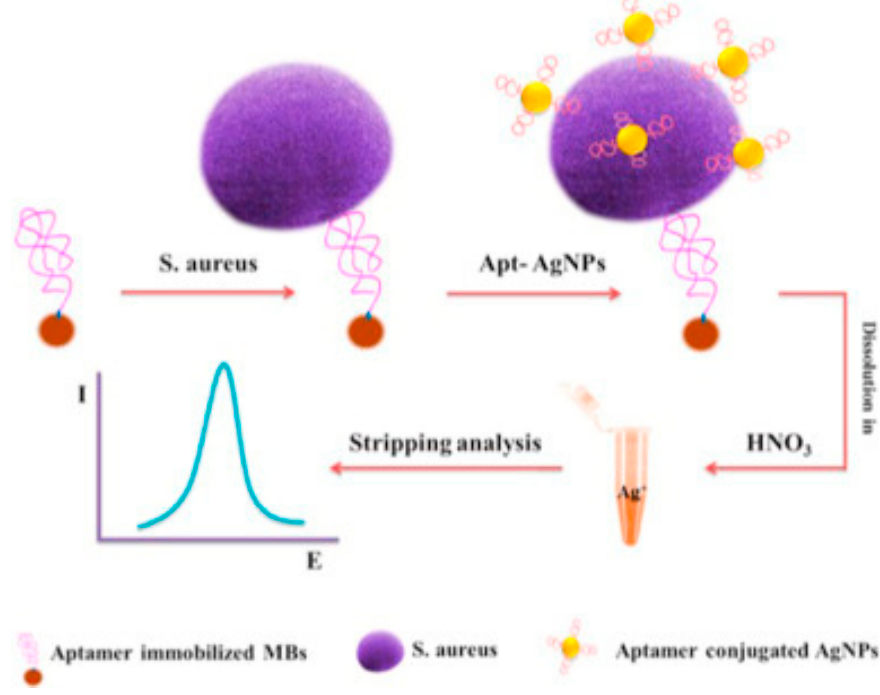
Figure 6. Example of electrochemical aptamer-based sensor with AgNPs labels and magnetic separation for detection of S. aureus (adapted with permission from [35]).